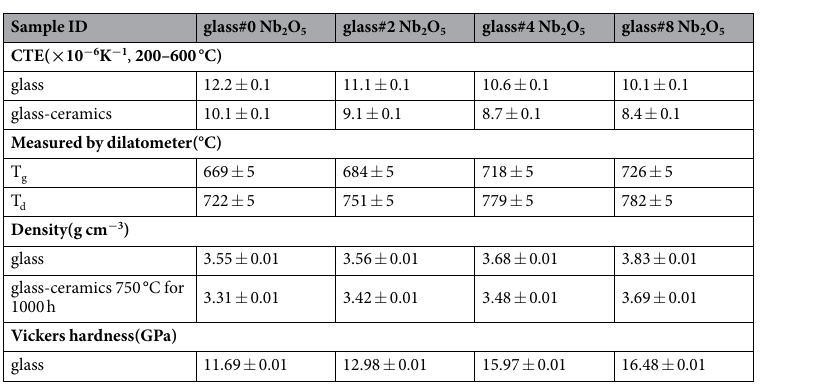
Table 2. Thermal and mechanical properties of glass and